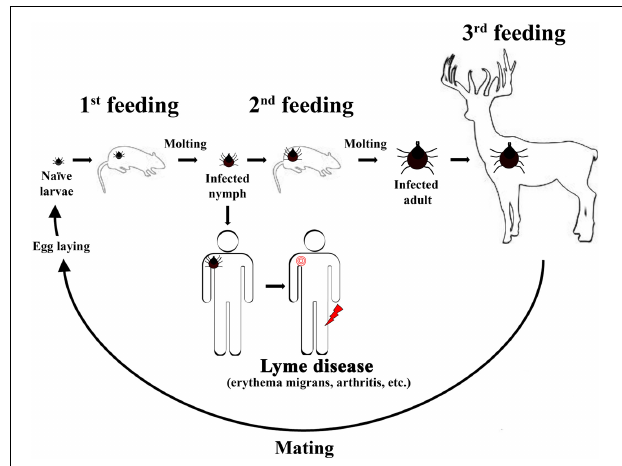
FIGURE 1 | The usual 2-year enzootic cycle of the Lyme disease spirochete. A naïve Ixodes scapularis larvae will feed on a small rodent near the end of the Summer season or early Fall. The feeding larvae can acquire Bb at this feeding (1st feeding) and remain colonized throughout the molting process, which occurs during the Winter season. For the 2nd feeding, infected nymphs will feed late in the Spring season or early in the Summer season. The infected nymphs transmit Bb to either a small rodent host, which maintains the enzootic cycle in nature, or humans (accidental host). Infected humans develop Lyme disease and may develop erythema migrans (signified by a red bulls eye near the shoulder in the figure shown) shortly after an infected nymph feeds. Typically, if subject to late Lyme manifestations Lyme disease patients develop Lyme arthritis at one or both knee joints (signified by a red lightning bolt near the knee in the figure shown). For the final feeding (3rd feeding), nymphs will molt and emerge as adults to feed on large mammals, such as deer, during the Fall season. Deer are considered incompetent hosts for Bb , but the 3rd feeding is important in the enzootic cycle because female ticks will mate and lay eggs over the Winter season. Naïve larvae will emerge following hatching and the cycle begins